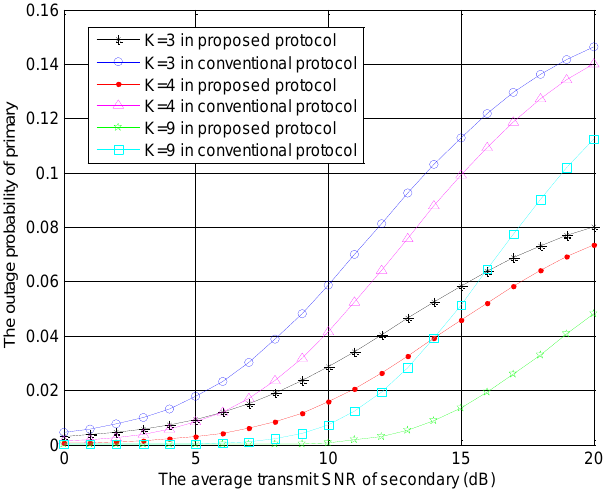
Figure 2. The outage probabilities of primary users versus r 2 with different K